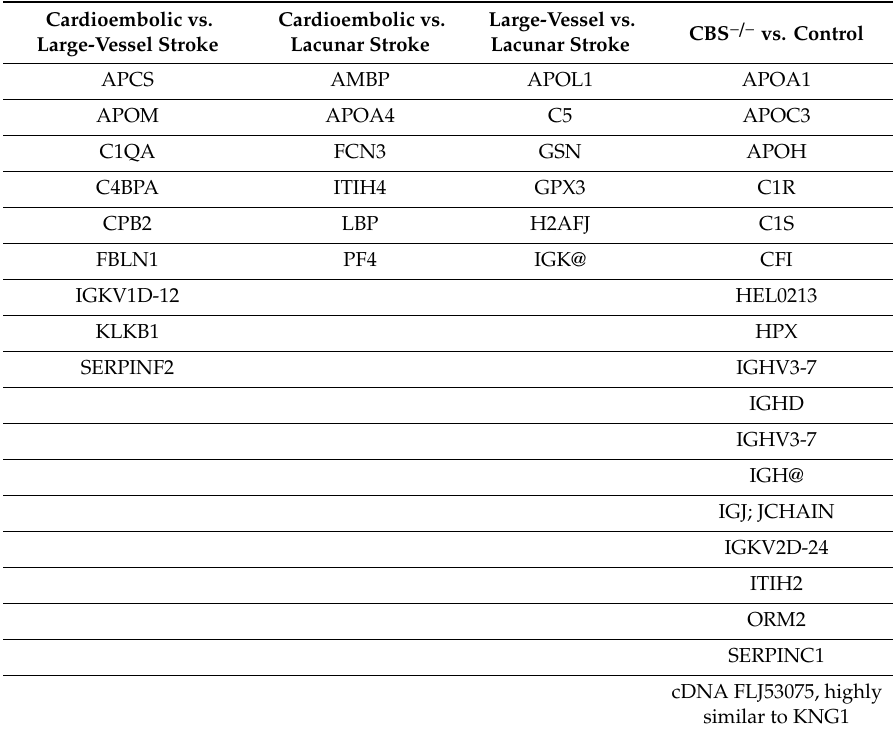
Table 4. List of stroke subtype- and CBS deficiency-specific proteins. Cardioembolic vs. Large-Vessel